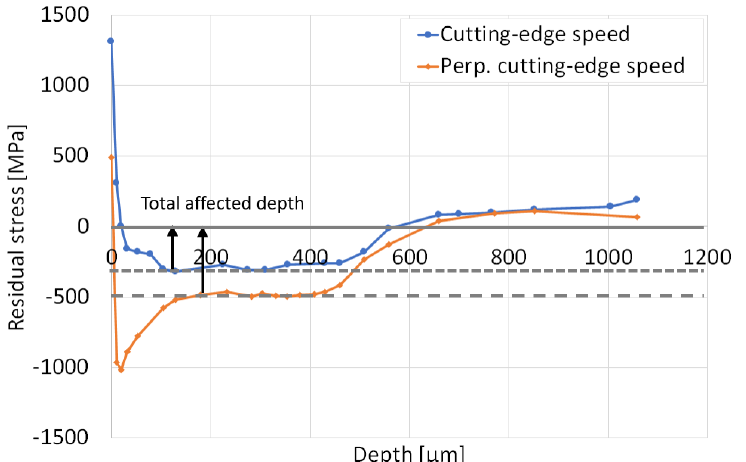
Figure 10. Envelope profiles, representing the accumulated profiles for all the maximum (compressive and tensile) values for all steps at the centre of the slot.